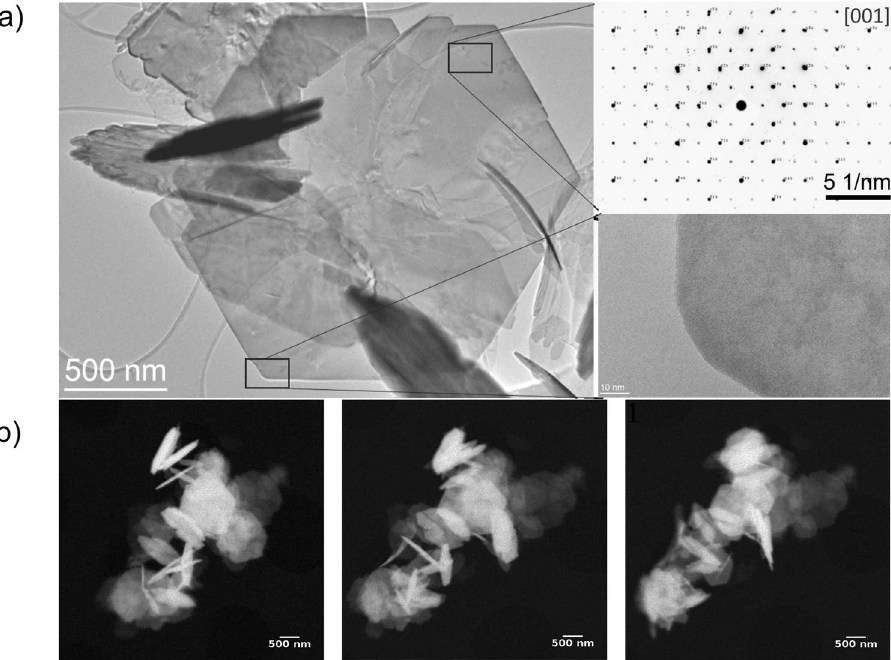
Figure 2. ( a ) TEM images and SAED of SFO particles synthesized at 503 K. ( b ) TXM images taken with a Fresnel zone plate of 25 nm showing the absorption contrast of the same cluster of SFO particles, at three different angles ( − 30°, 0°, 30°). Effective pixel size = 10 nm.